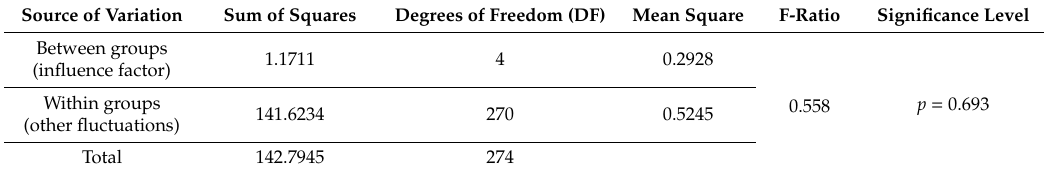
Table 4. Group di ff erences in Table 4. Group differences in PAQ ‐ C.